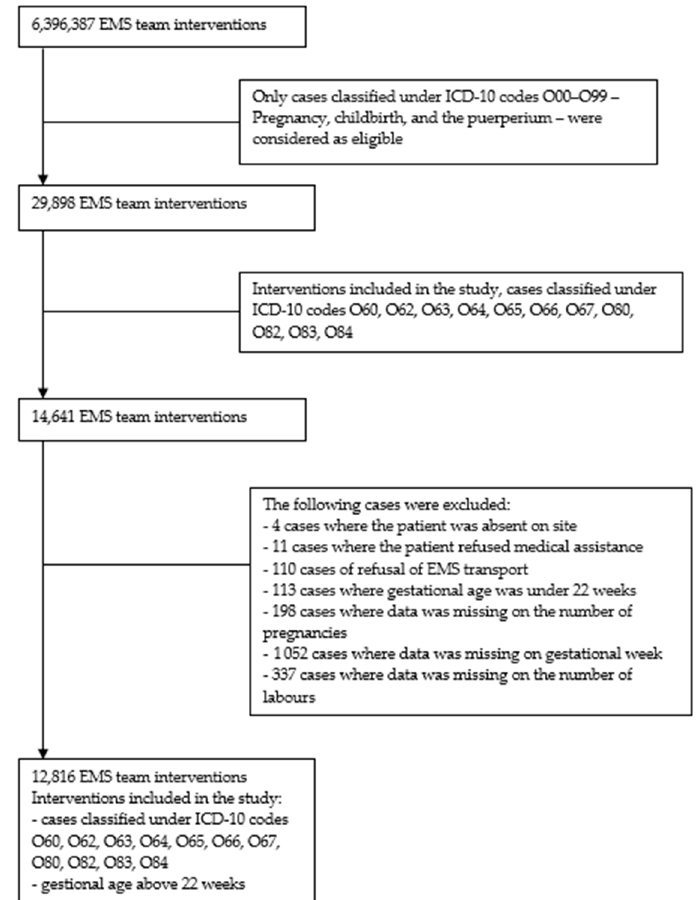
Figure 1. Flowchart of the recruitment process of EMS team interventions in cases of suspected labour (N = 12,816).